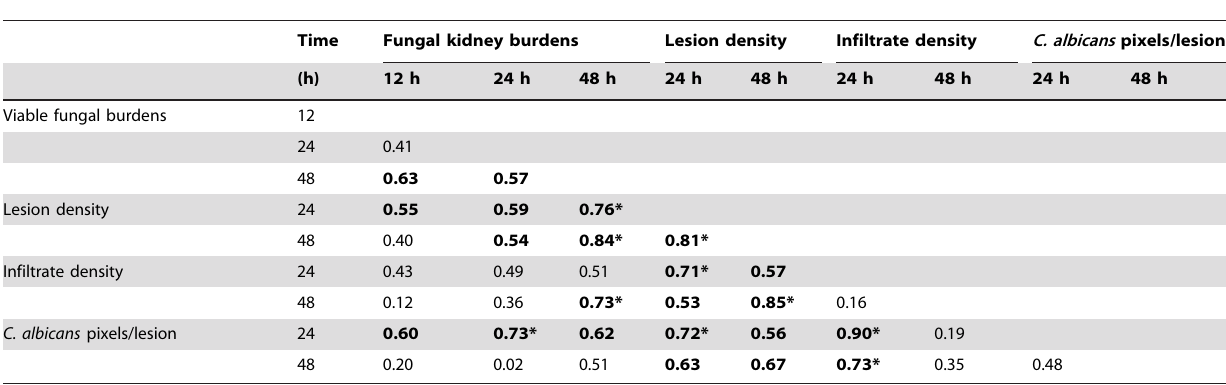
Table 2. Correlation coefficients (Pearson r ) cross-tabulated for means of lesion data for 11 C. albicans strains.